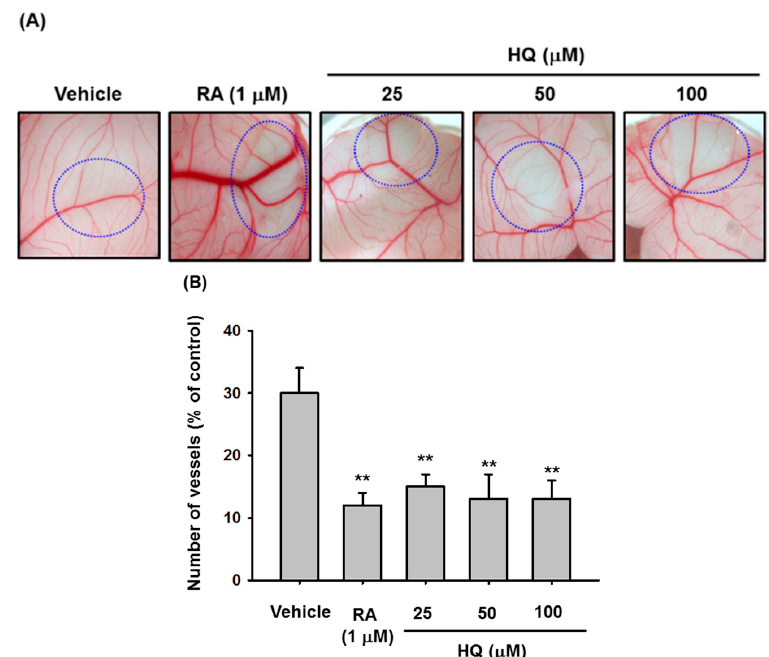
Figure 4. Effect of HQ on the blood vessel generation. ( A , B ) Fertilized chicken eggs were treated with either vehicle, RA, or the indicated doses of HQ (circle areas) at 37 °C for 3 days, and the vasculatures in the fertilized chicken eggs were photographed ( A ). Numbers of vessels at drug-treated area were counted by a counter ( B ). ** p < 0.01 compared to the vehicle control.